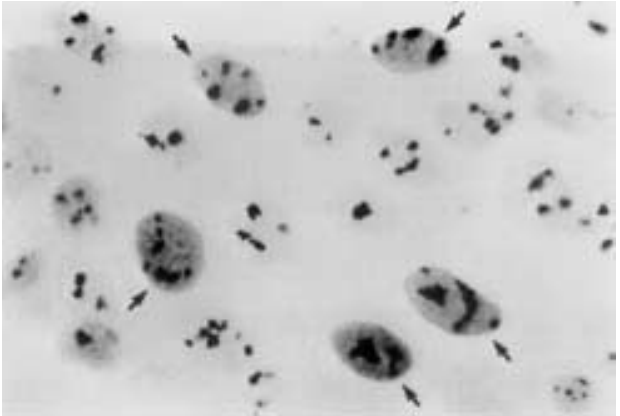
Fig. 1. Bladder tumor (grade 3, invasive) stained with AgNORs and monoclonal antibody MIB-1. A number of AgNOR dots are observed in MIB-1 positive nuclei (arrows) compared with MIB-1 negative nuclei. No counterstaining was performed. Original magnification, ×